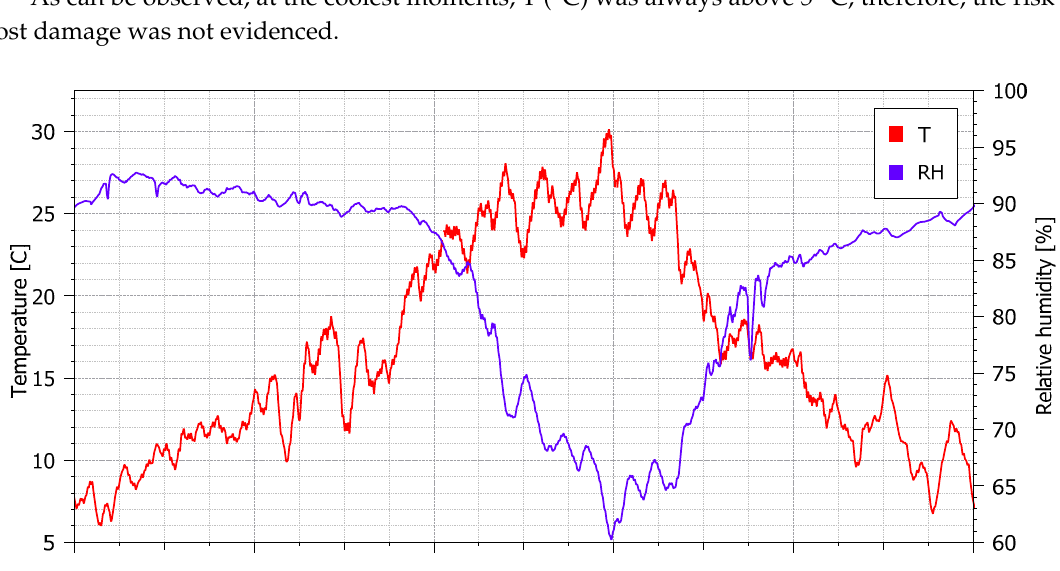
Figure 13. T (°C) and RH (%) profiles of the simulated wall in point C, during the 2nd year of